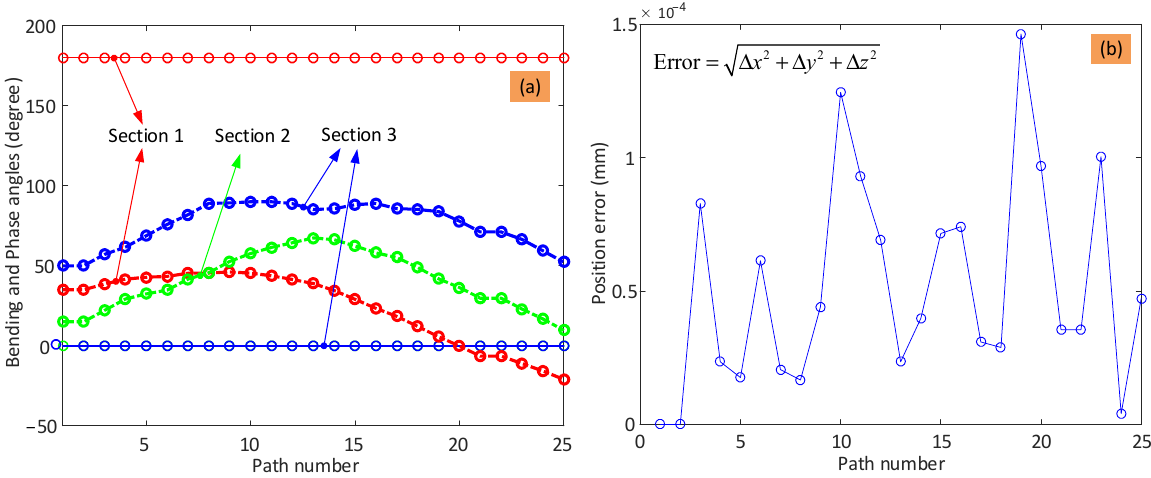
Figure 11. Shape parameters of the 6-DoF continuum arm and the optimization accuracy: ( a ) is the bending angle and phase angle as the end effector moves from point to point; ( b ) is the position error at each point.